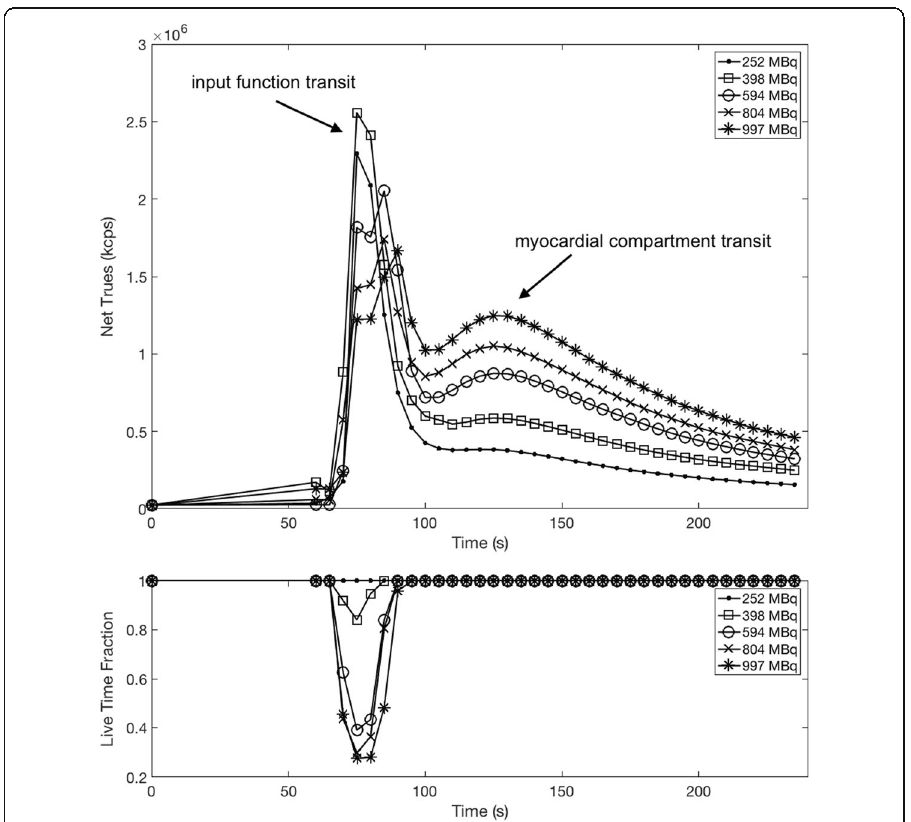
Fig. 4 Top — Net trues and prompt rates from each injected activity experiment performed with the cardiac perfusion phantom. Of note is that above a net trues rate of approximately 2.6 × 10 6 (corresponding to A INJ = 398 MBq), the trues rate at peak input function actually begins to decrease due to the decrease in live-time